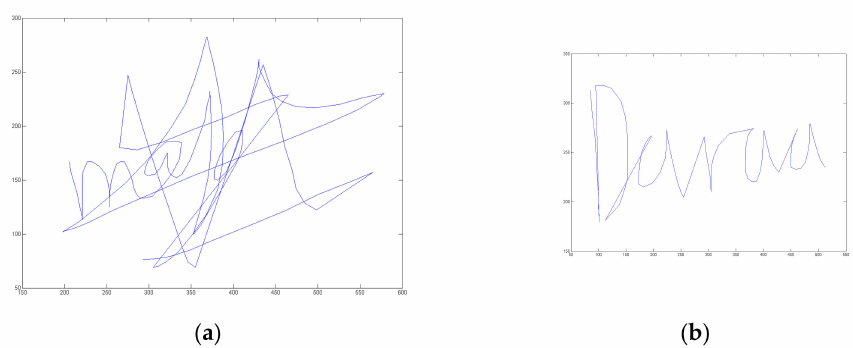
Figure 1. Examples of ( a ) a usual signature and ( b ) the associated place information of a user who authorized their publication.